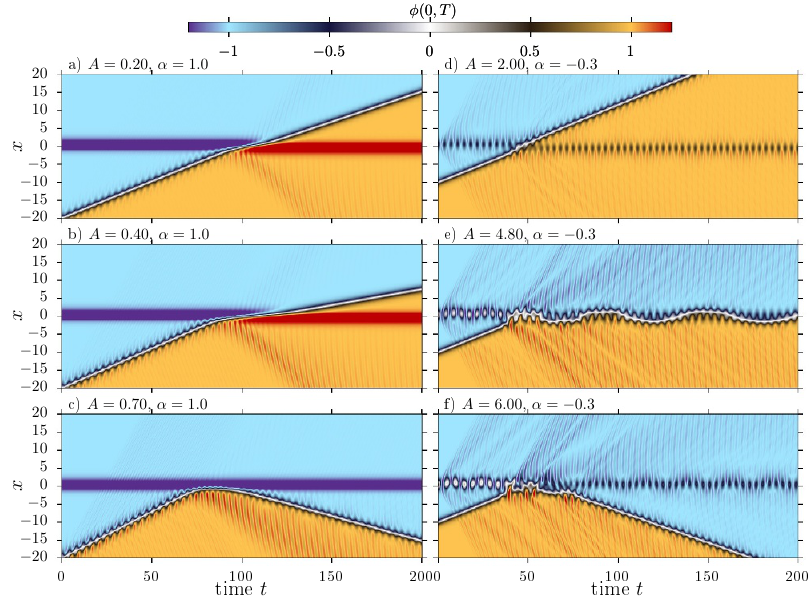
Figure 18 . Di(cid:11)erent scenarios of perturbed antikink-impurity ( (cid:22) K (cid:3) + (cid:6), left panel) and antikink- perturbed impurity ( (cid:22) K + (cid:6) (cid:3) , right panel) collisions. The parameter values are a) A = 0 : 2, (cid:11) = 1, b) A = 0 : 4, (cid:11) = 1, c) A = 0 : 7, (cid:11) = 1, d) A = 2, (cid:11) = (cid:0) 0 : 3, e) A = 4 : 8, (cid:11) = (cid:0) 0 : 3 and f) A = 6, (cid:11) = (cid:0) 0 :